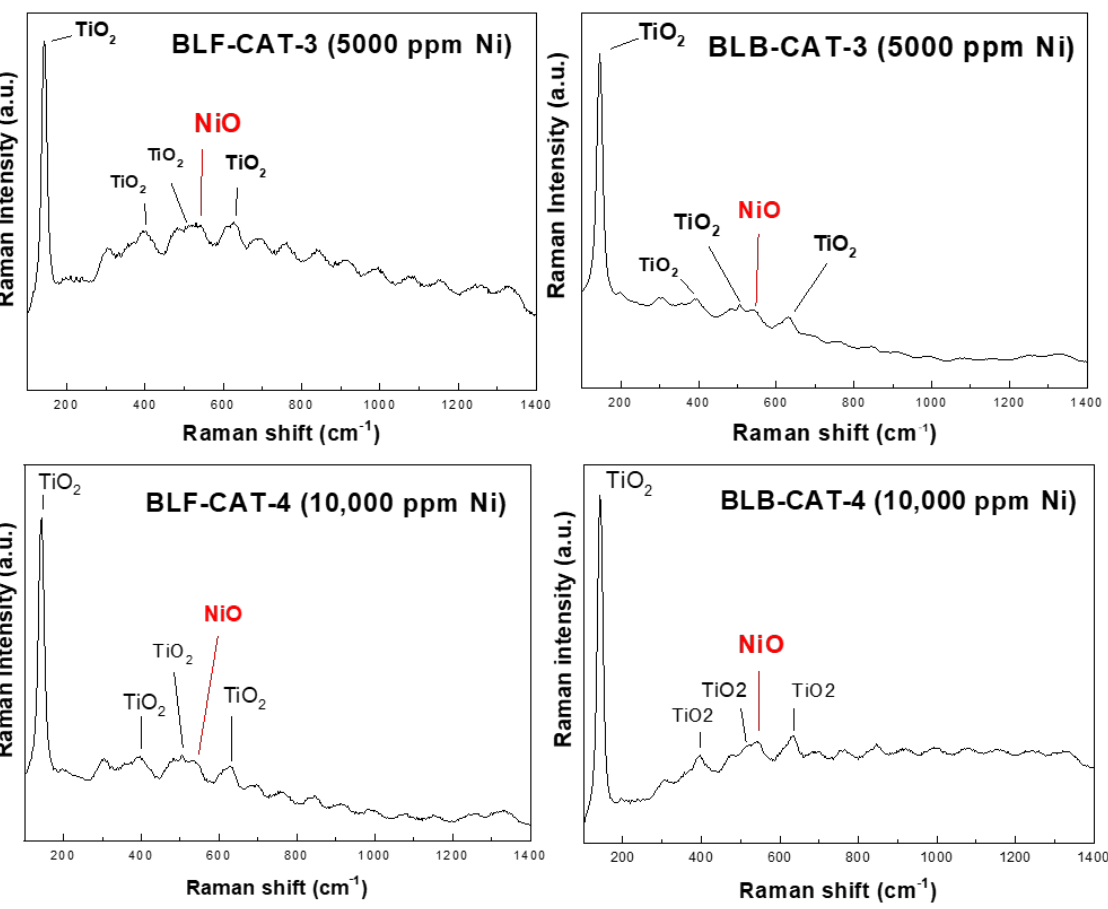
Figure 13. Raman spectra of Ni-loaded FCC catalysts: BLF-CAT-3 and BLB-CAT-3 (also containing boron) with 5000 ppm Ni, and BLF-CAT-4 and BLB-CAT-4 (also containing boron) with 10,000 ppm Ni.